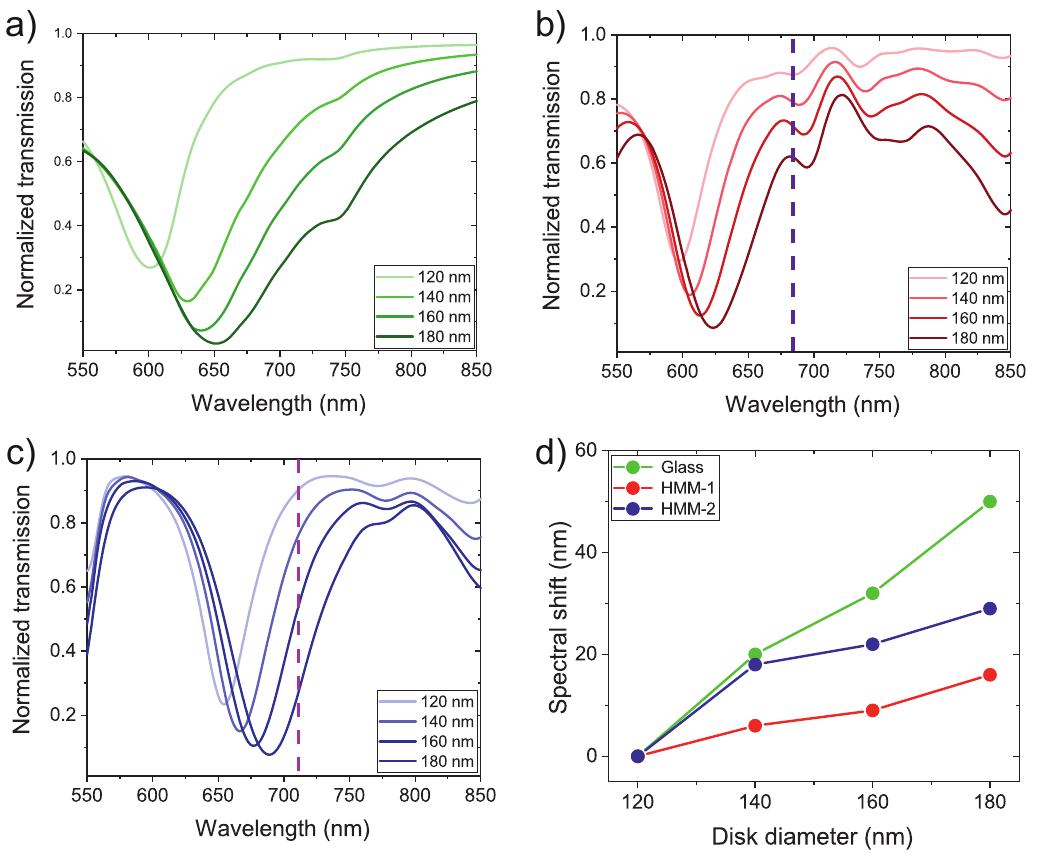
Figure 2: Evolution of the plasmon resonance with varying diameters of NDs on (a) glass (b) HMM-1, (c) HMM-2 and (d) spectral shift of the resonance, calculated by FDTD simulations. FDTD, finite-difference time-domain; HMM, hyperbolic metamaterial; ND,